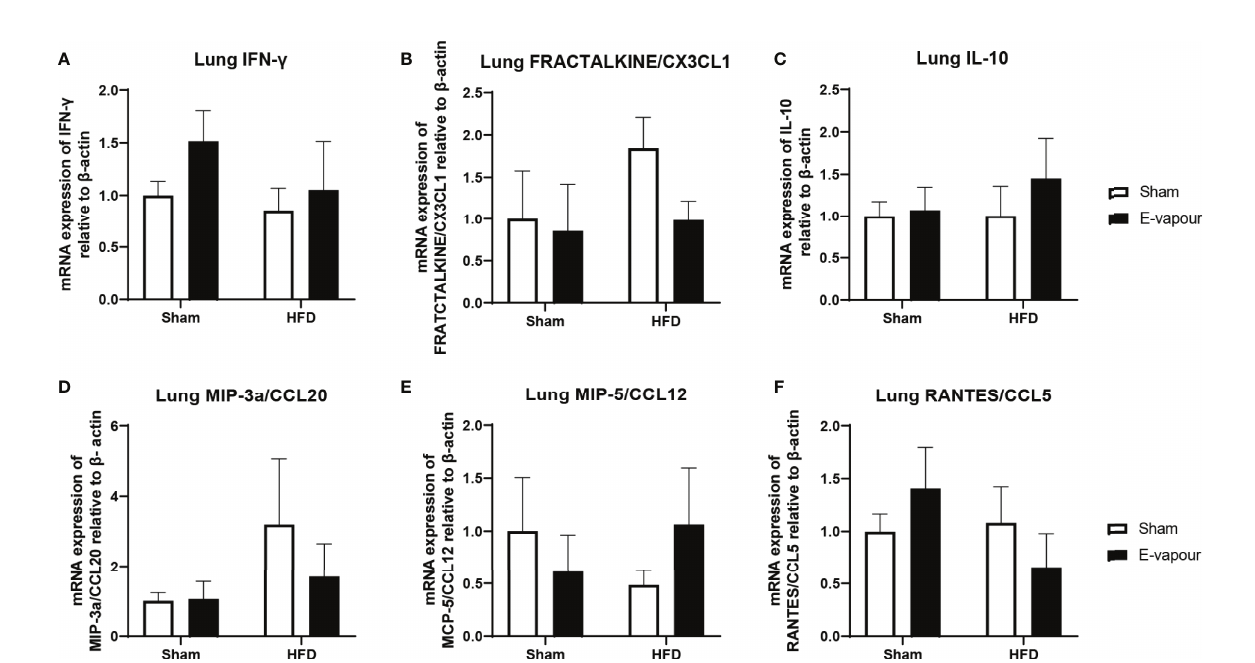
FIGURE 2 | mRNA expression of IFN- g (A) , FRACTALKINE/CX3CL1 (B) , IL-10 (C) , MIP-3a/CCL20 (D) , MCP-5/CCL12 (E) , and RANTES/CCL5 (F) in the lung. Results are expressed as mean ± SEM, n=5.